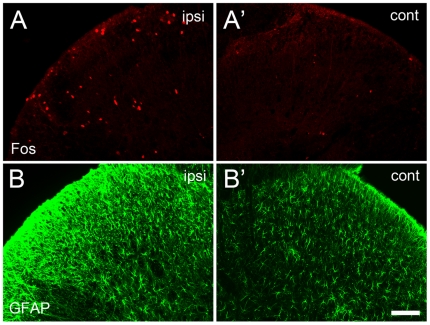
Immunofluorescent staining for Fos and GFAP in the spinal dorsal horn after SNL.A–A', SNL induced a significant up-regulation of Fos expression in the ipsilateral dorsal horn 2 h after SNL. B–B', GFAP immunoreactive astrocytes were significantly activated 1 w after nerve injury in the ipsilateral compared to the contralateral dorsal horn. Scale bar = 200 µm.